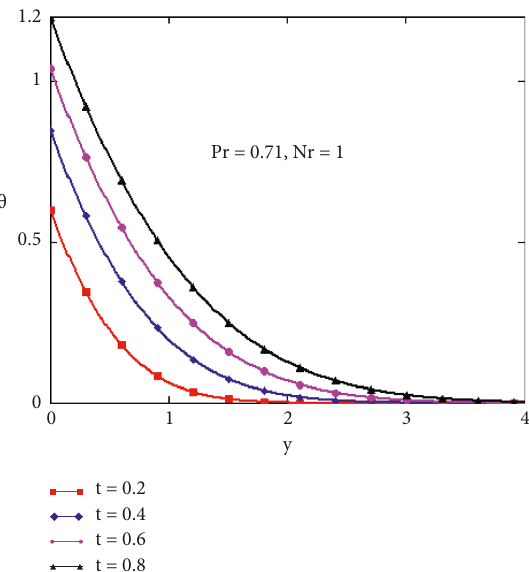
Figure 7: Temperature profile for different values of t .